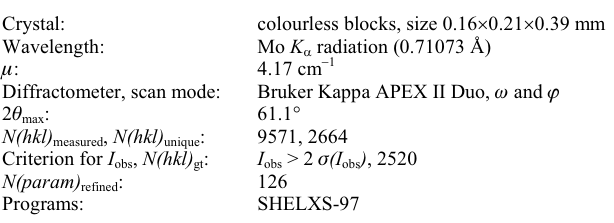
Table 1. Data collection and